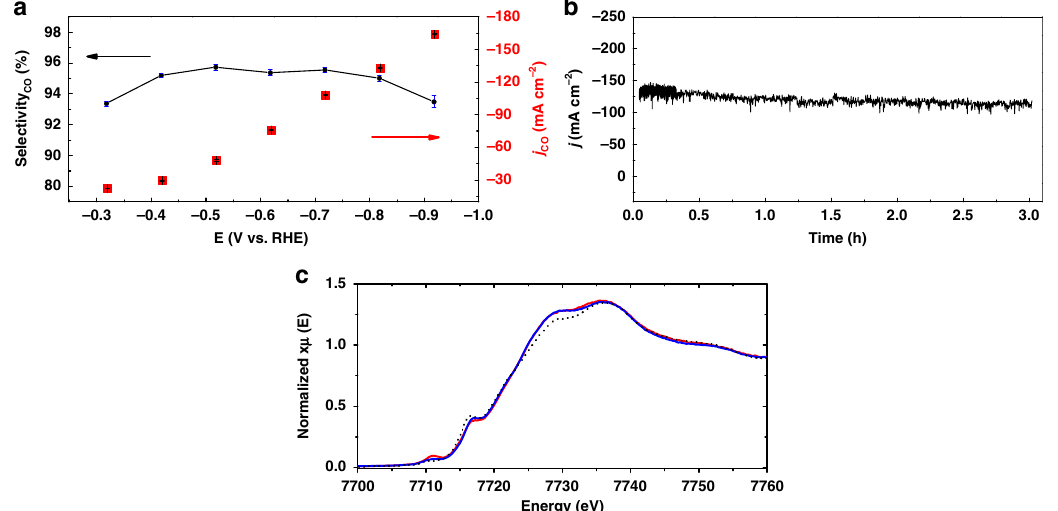
Fig. 5 Controlled potential electrolysis and CoPc2 fi lm characterization. a Current density and selectivity for CO production as a function of the potential and b bulk electrolysis at fi xed potential ( E = − 0.72 V vs. RHE) for CoPc2 @carbon black deposited onto a carbon paper as cathodic material, in 1 M KOH. c Co K-edge XANES pro fi les of CoPc2 (black dots) and CoPc2 @carbon black before (blue) and after electrolysis ( E = − 0.72 V vs. RHE) (red) in 1 M KOH